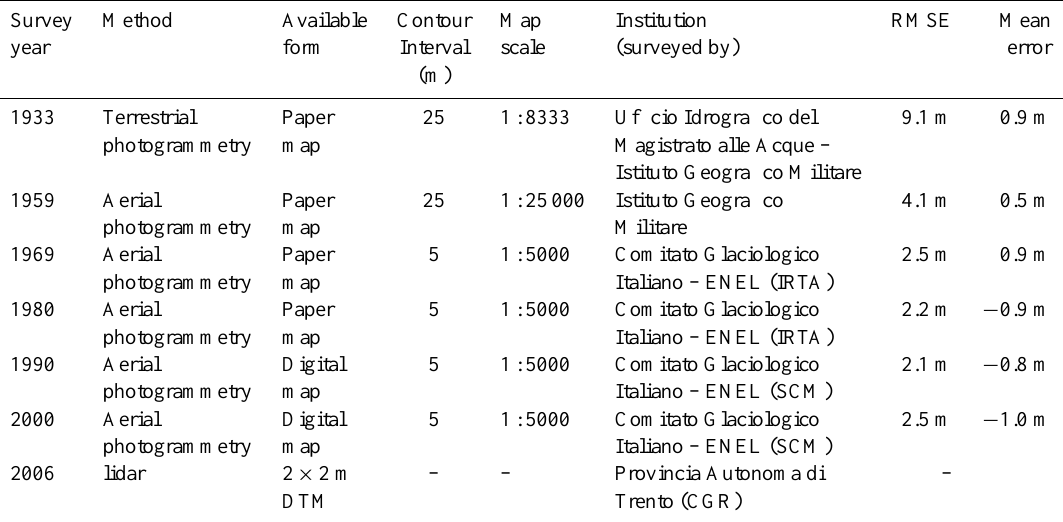
Table 1. Characteristics of the topographic surveys available for the calculation of area and volume changes of Careser Glacier. RMSE and mean error refer to the 2006